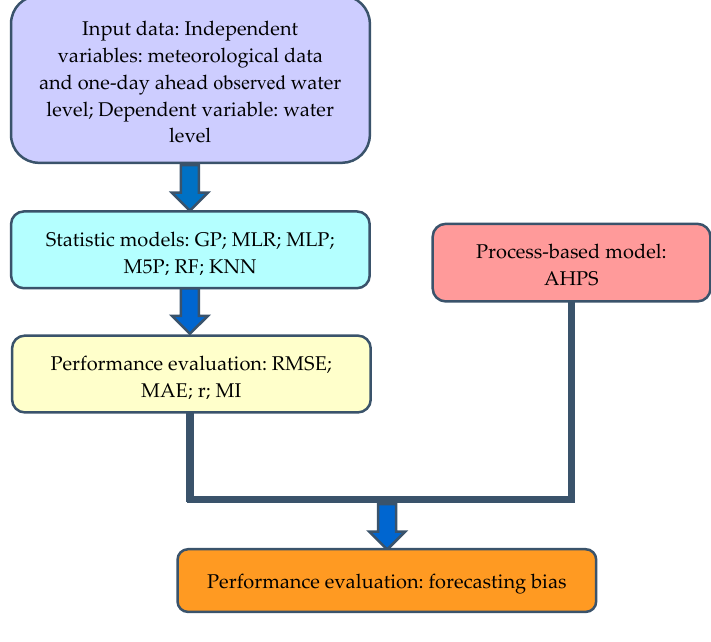
Figure 1. Flow chart of this paper.